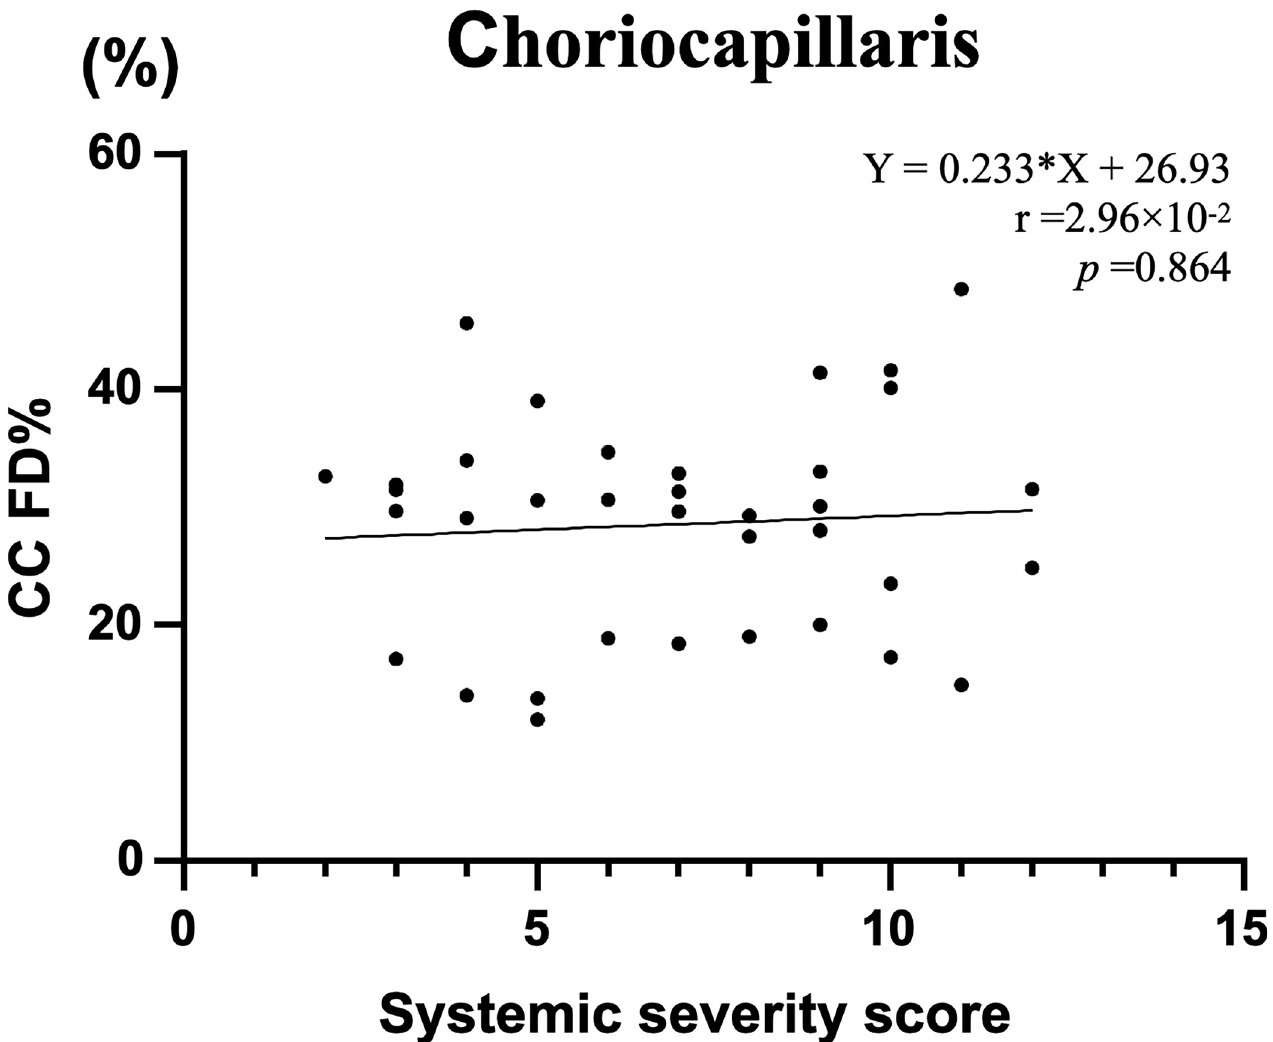
Fig 2. Spearman’s rank correlation analysis showed no significant correlation between choriocapillaris flow deficit percentage (CC FD%) and the systemic severity score.